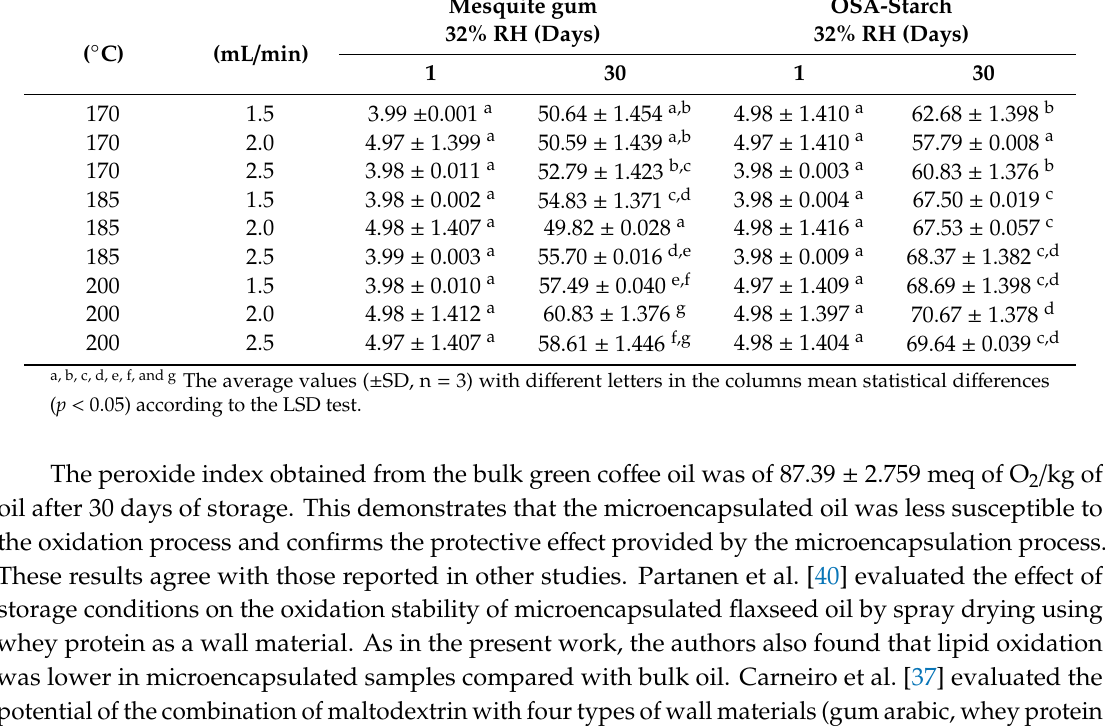
Table 4. Peroxide index in the microcapsules obtained with mesquite gum and OSA-starch. Spray Drying